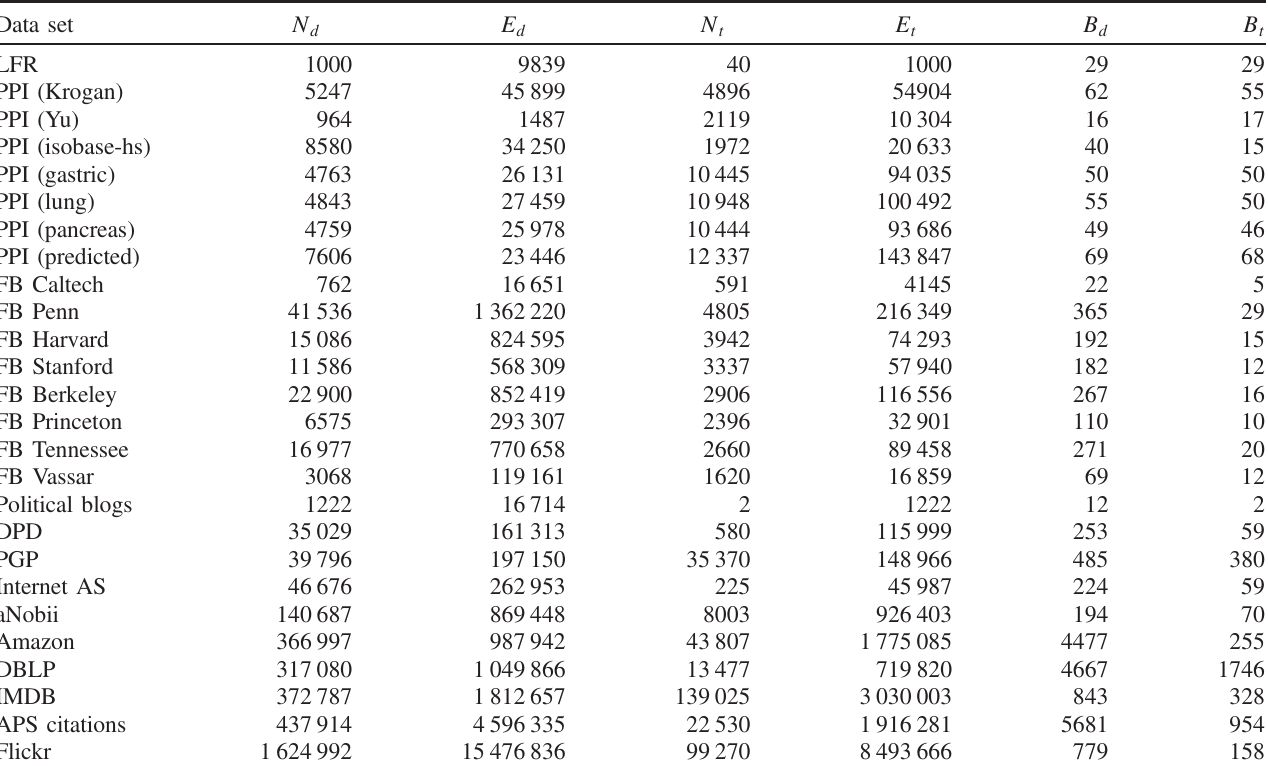
TABLE I. Summary of the basic statistics of the data sets used in this work. N d and E d are the number of data nodes and data-data edges, respectively, whereas N t and E t are the number of metadata tags and node-tag edges, respectively. B d and B t are the number of data and metadata groups inferred with our